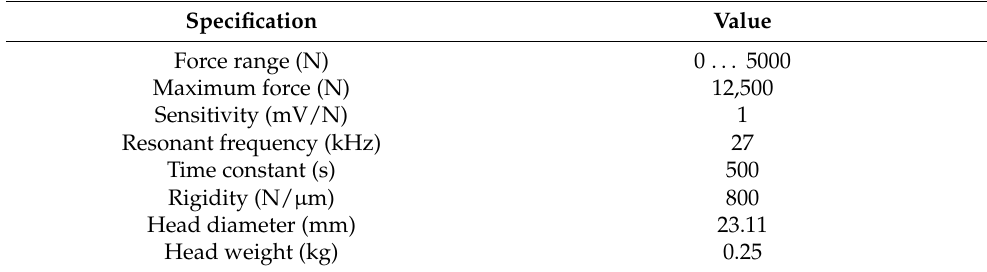
Table 3. Technical specifications of the Kistler impact